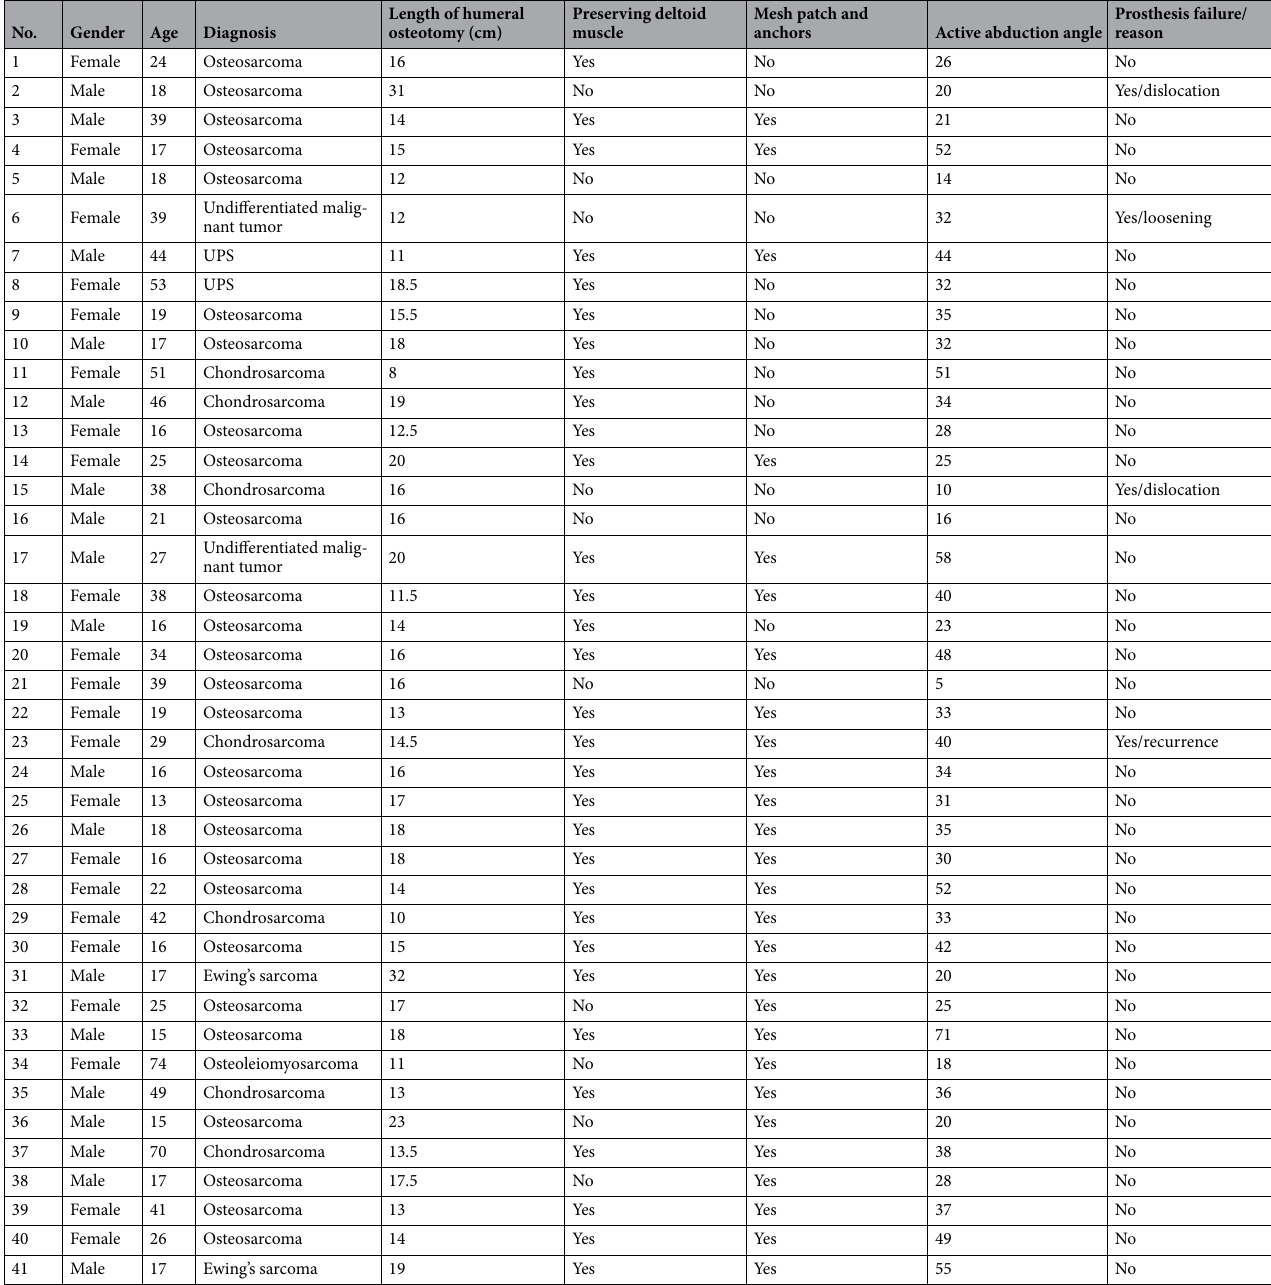
Table 1. Clinical characteristic of the patients. UPS undifferentiated pleomorphic